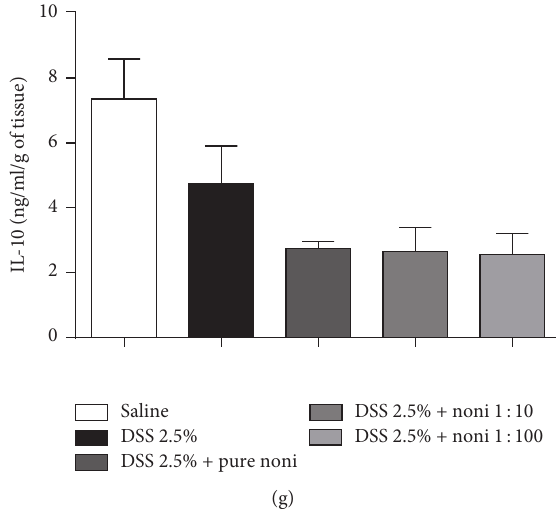
Figure 4: Noni fruit juice consumption reduces key inflammatory cytokines in the intestine in a dose-dependent manner. C57BL/6 mice were exposed to dextran sulfate sodium (DSS) 2.5% and treated daily with noni fruit juice. Enzyme-linked immunosorbent assay (ELISA) was performed in gut homogenates. (a) TNF- 𝛼 , (b) IL-12, (c) IFN- 𝛾 , (d) IL-17, (e) IL-23, (f) IL-4, and (g) IL-10. Results were expressed as nanograms of cytokine per milliliter per gram of tissue (ng/ml/g of tissue), normalized by tissue dry weight. Data are represented as mean ± SEM. ∗ 𝑝 < 0.05